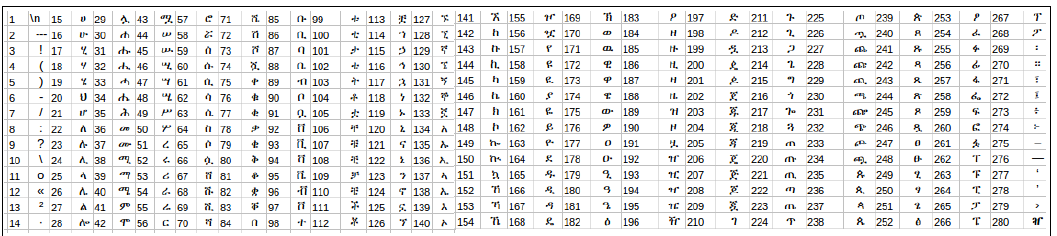
Figure 3. Unique Amharic characters and punctuation marks presented in the ground truth of the Amharic OCR database [9].